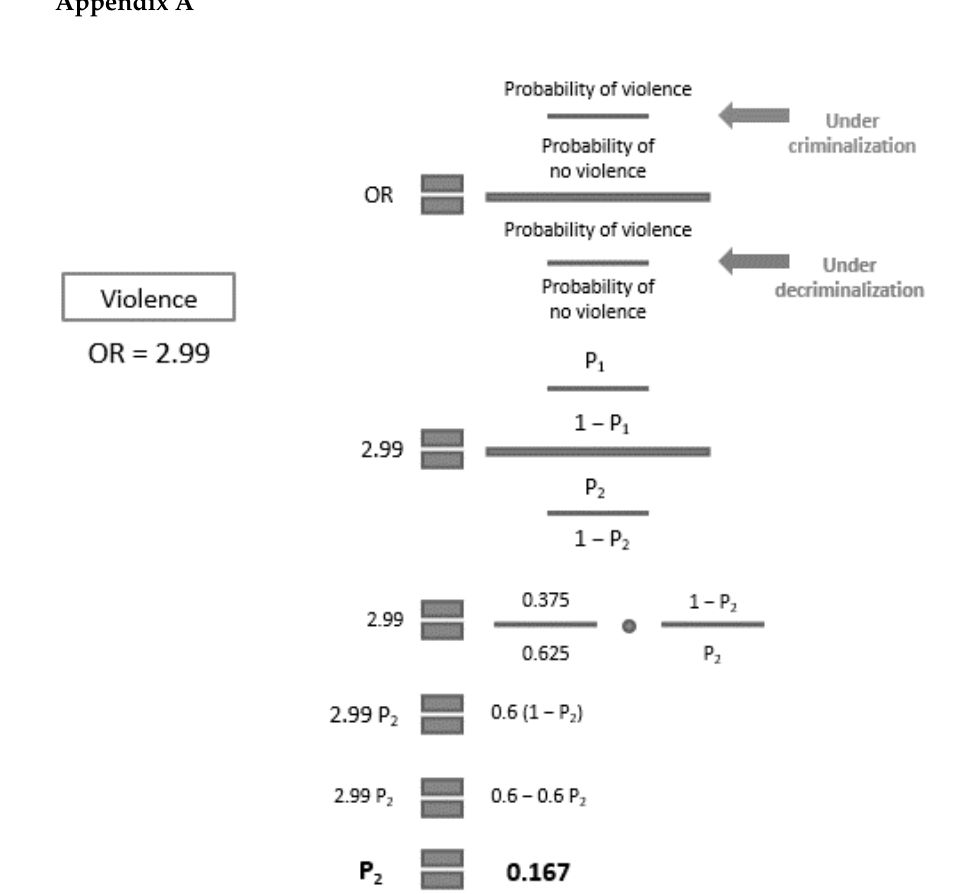
Figure A1. Incidence of violence in sex workers following decriminalization.